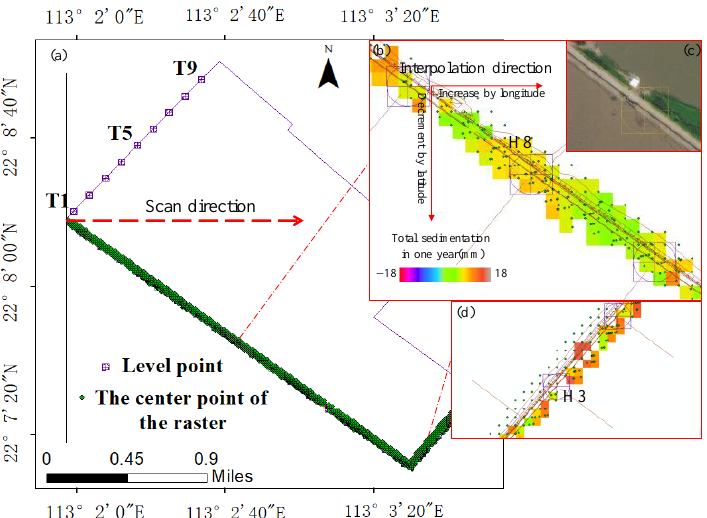
Figure 19. ( a ) All grid centers with settlement values and the overall interpolation direction of the seawall road section. T1-T9 is the 9 level monitoring points on the soil embankment road. ( b ) Interpolation examples near the level point H8 of the Seawall road are the real settlement area after InSAR fusion. The red line is the line map of the road terrain ( c ) the optical image of the road near H8, and ( d ) the settlement law of the H3 level section of HaiDi Road, whose default value type is completely